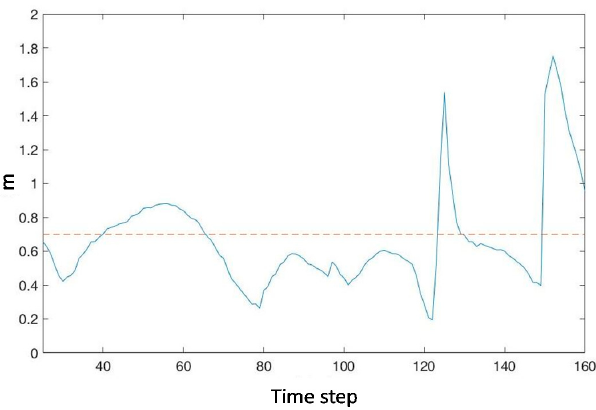
Figure 13. The distance measurements from the laser sensor at 90° when the robot executes the OBF behavior in the period from time steps 25 to 160.